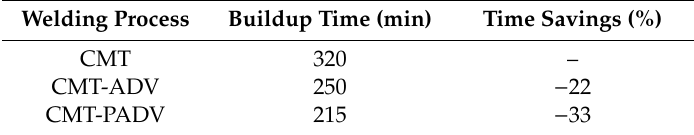
Table 2. Comparison of the buildup time of the di ff erent arc modes for the large-volume wall structures.